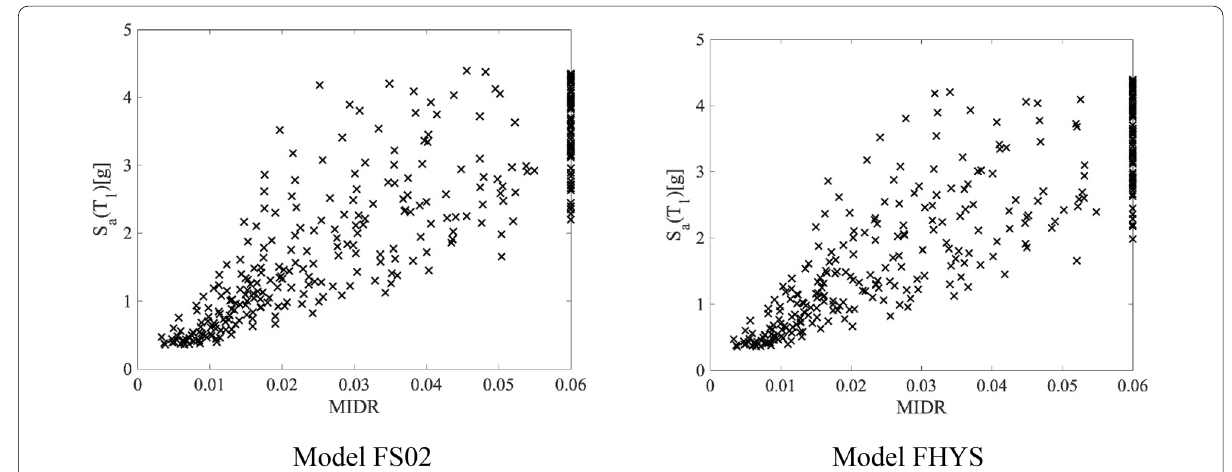
Fig. 11 Scatter plot showing demands for two modeling options using CSS motions.